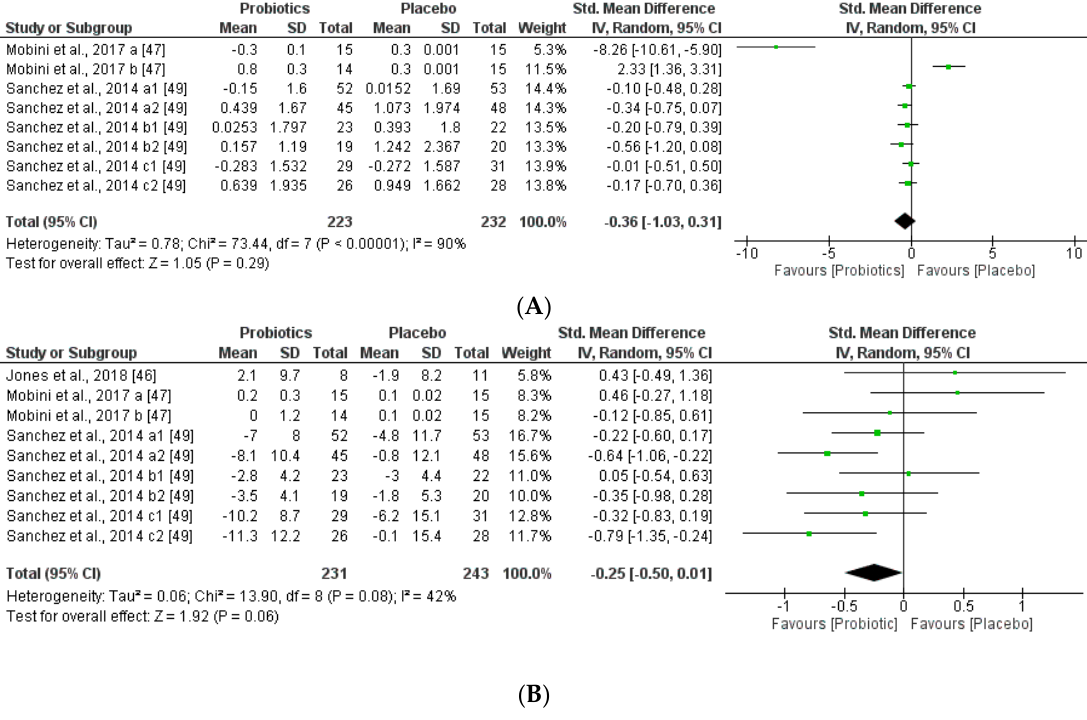
Figure 11. ( A ) Effect of probiotics on adiponectin in CT. ( B ) Effect of probiotics on leptin in CT. Figure 11. ( A ) E ff ect of probiotics on adiponectin in CT. ( B ) E ff ect of probiotics on leptin in